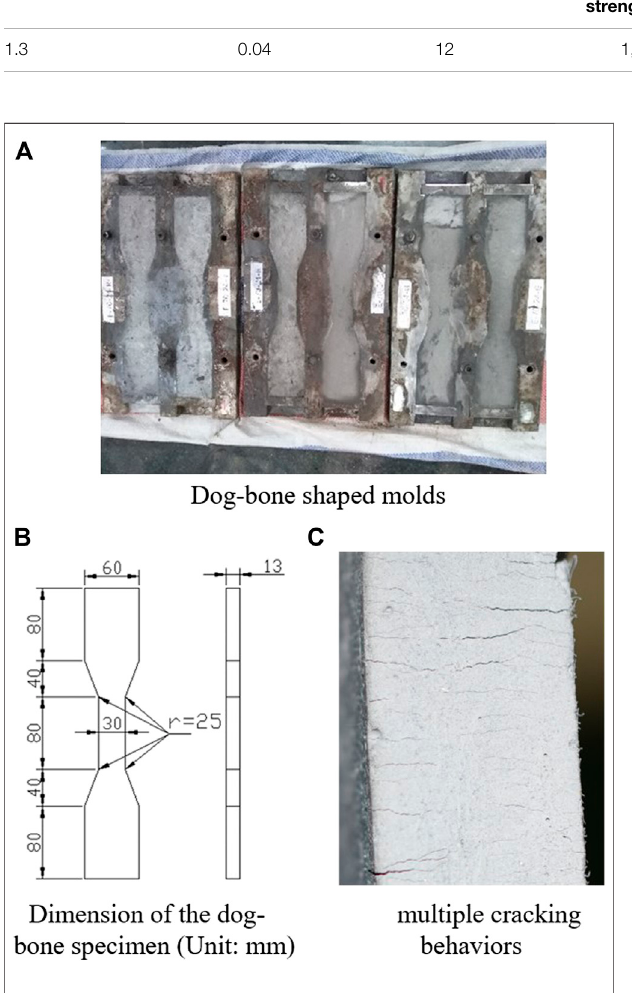
FIGURE 1 | Design and performance of the adapted ECC in the experiment.